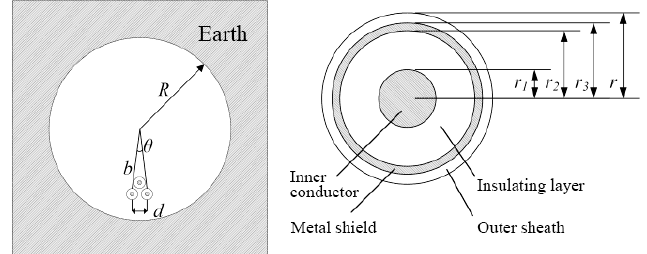
Figure 2. Cross section of tunnel-installed cable system and structure of cable.